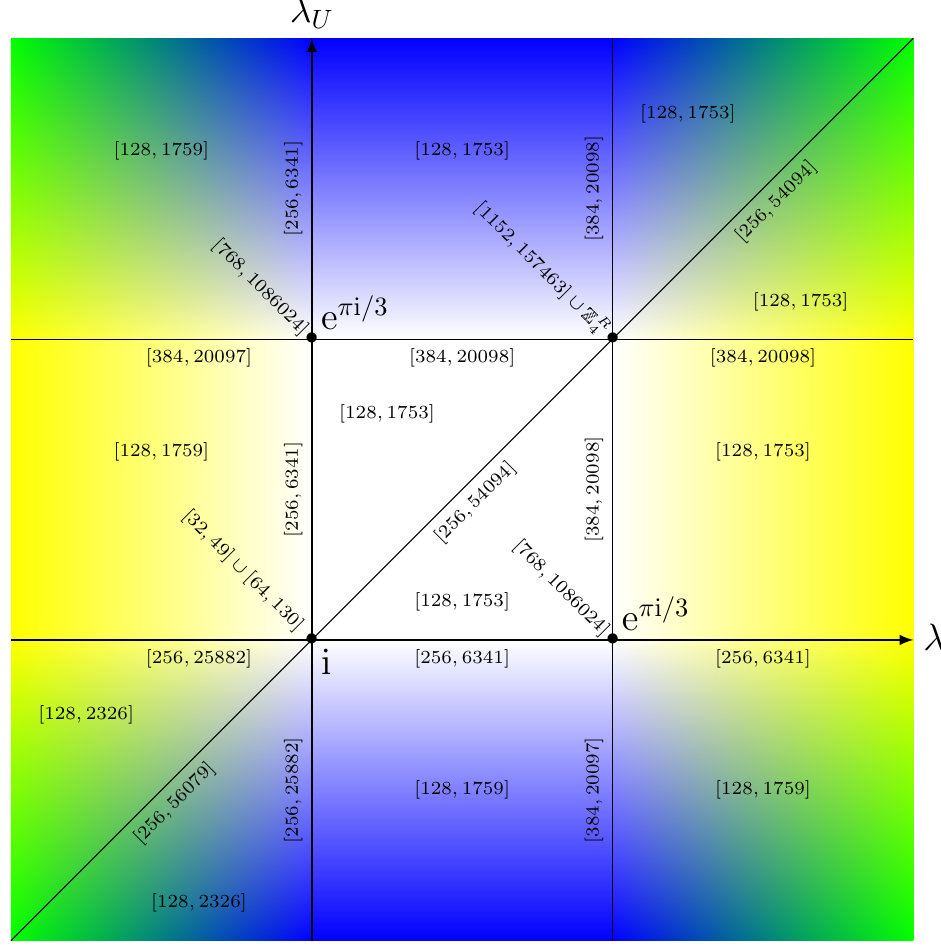
Figure 3. Unified flavor groups with CP at h T i ∈ λ T and h U i ∈ λ U . We use the shorthands (cid:3) ∼ = (cid:2) [1152 , 157463] × Z R [32 , 49] ∪ [64 , 130] ∼ = (cid:2) [32 , 49] × [64 , 130] (cid:3) / Z and [1152 , 157463] ∪ Z R / Z 2 , 2 4 4 where the Z corresponds to the point group selection rule of the T 2 / Z orbifold sector, contained 2 2 in both groups in the product. The axes λ and λ describe the boundaries of the fundamental T U domains of T and U , see e.g. figure 2 for λ . The diagonal depicts the hypersurface where h U i = h T i T on the curves λ and λ . The unified flavor groups above and below the diagonal are related by T U mirror symmetry ˆ M